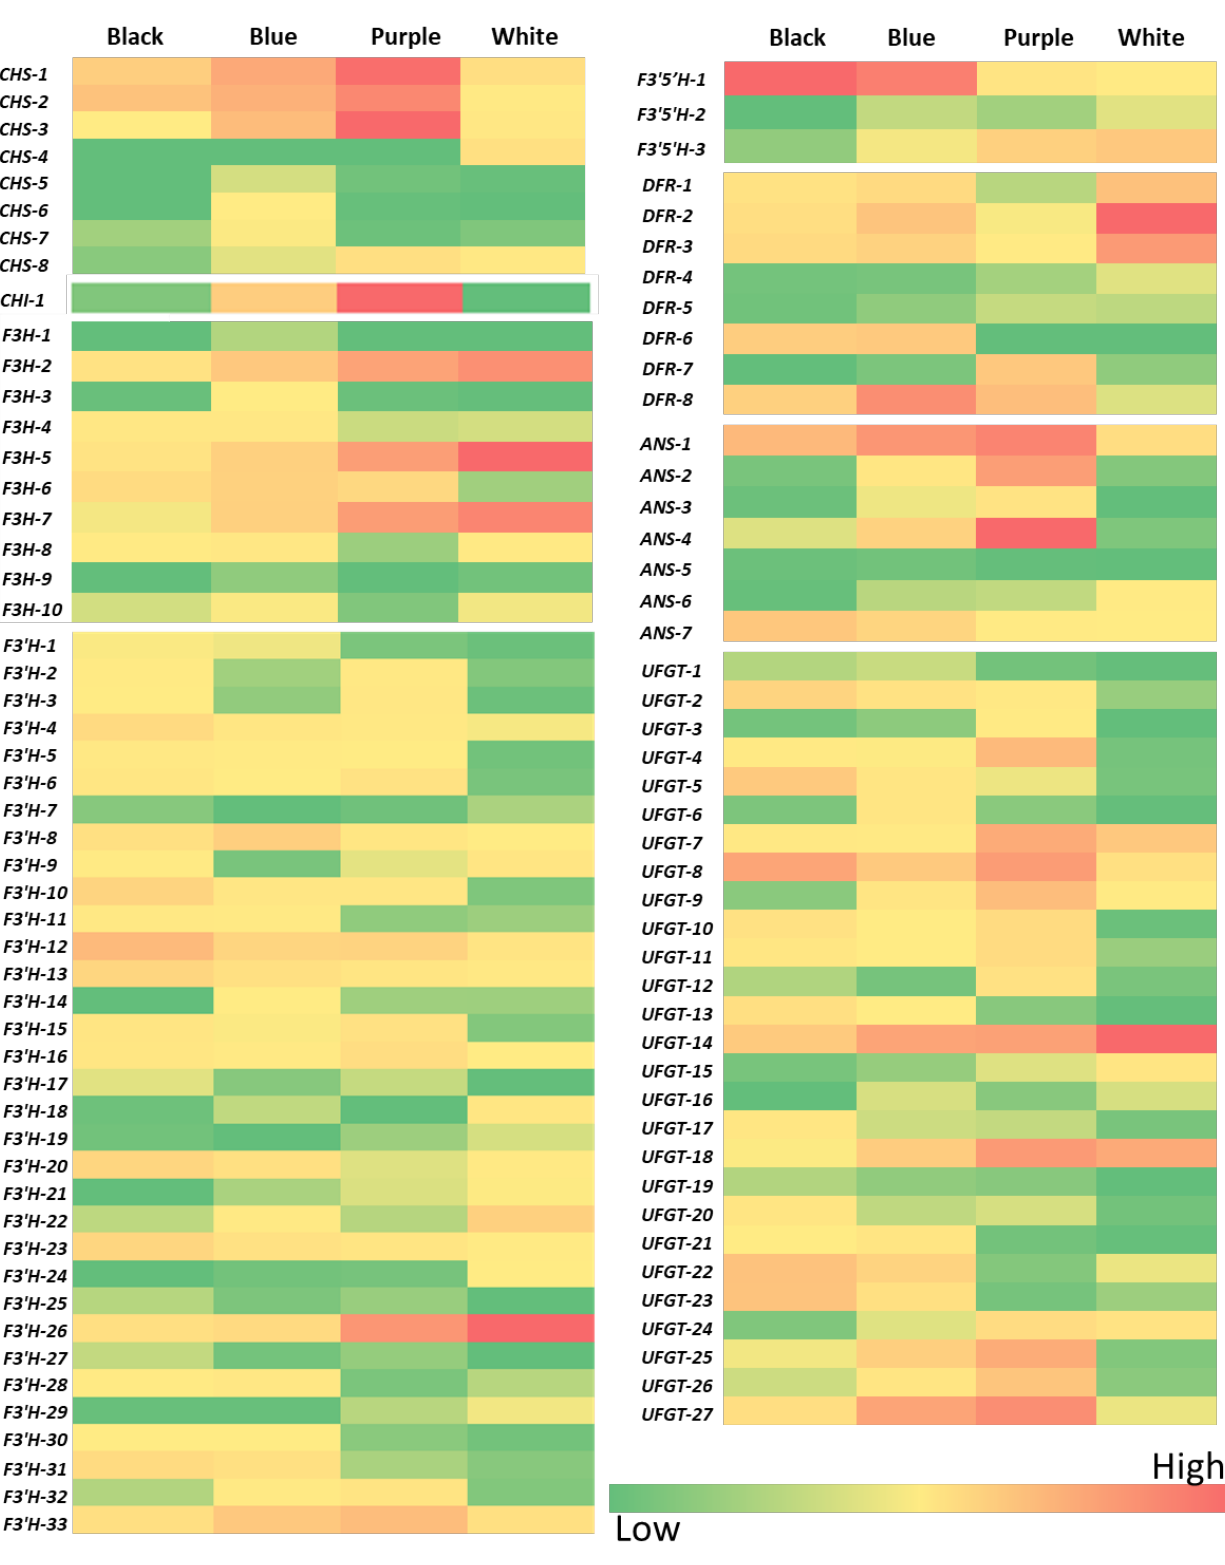
Figure 2. Heatmaps depicting the relative expression of studied genes in different colored wheat lines .